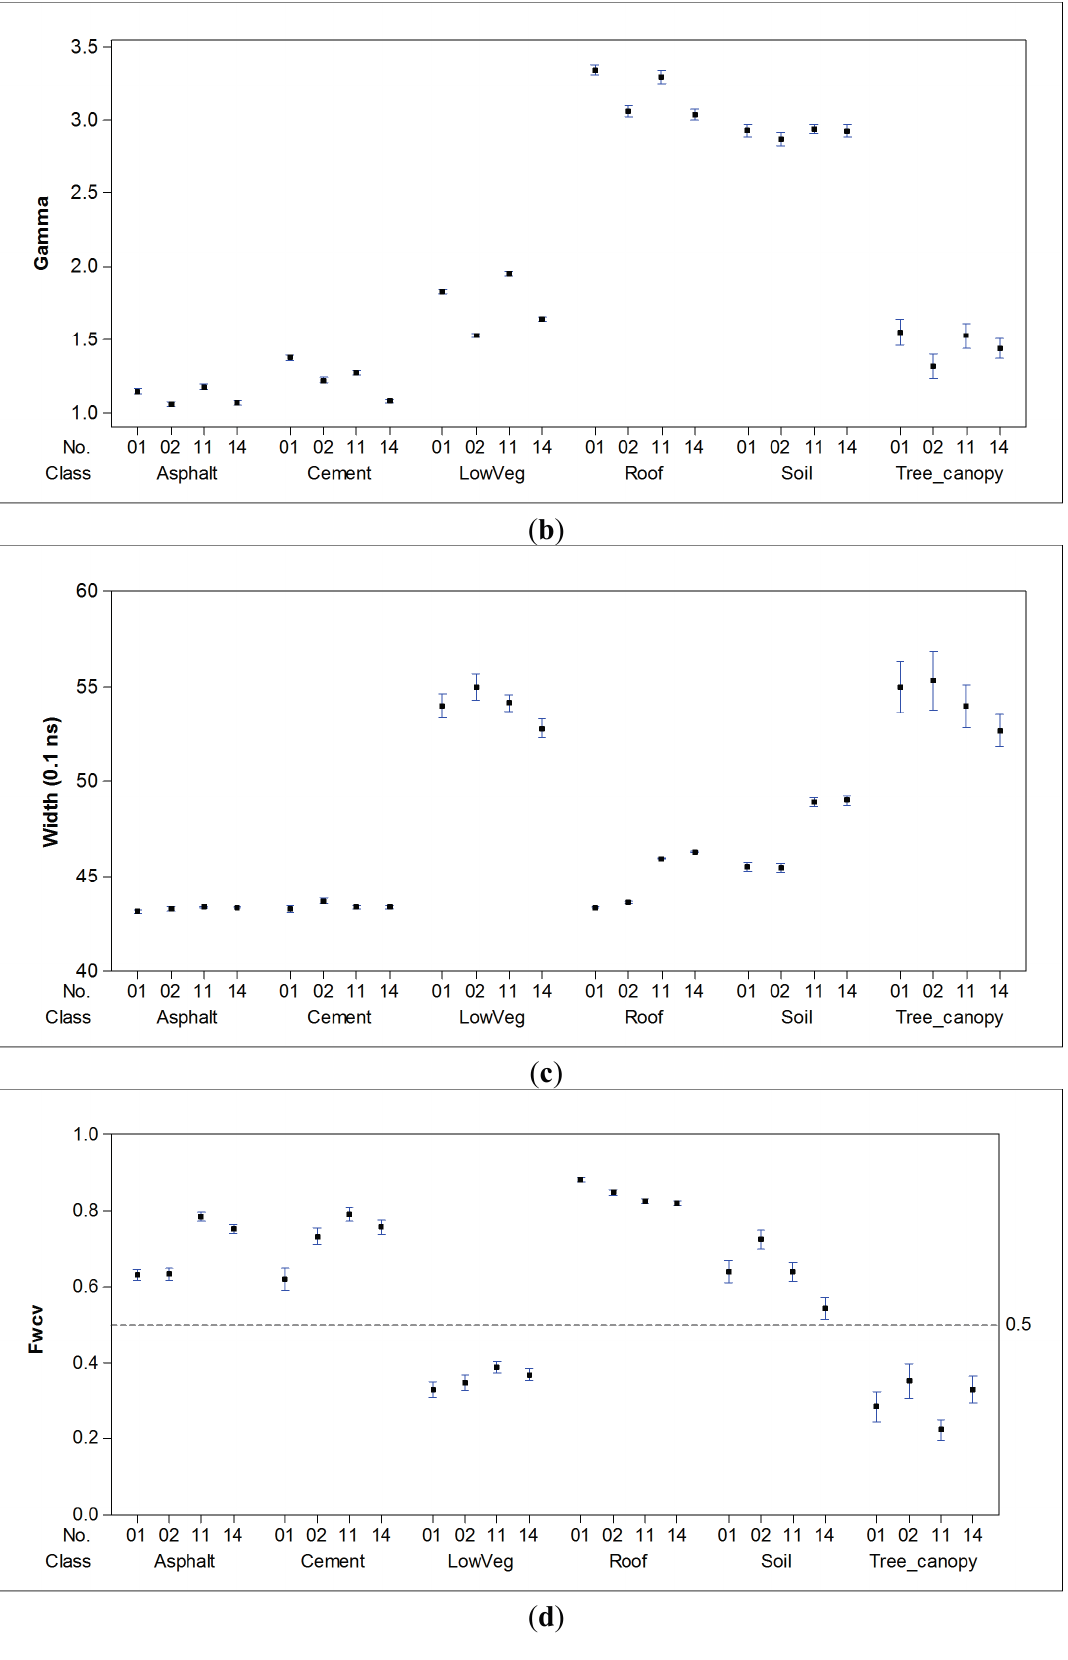
Figure 7. Interval plots of the ( a ) linearized amplitude, ( b ) backscatter coefficient, ( c ) width, and ( d ) normalized